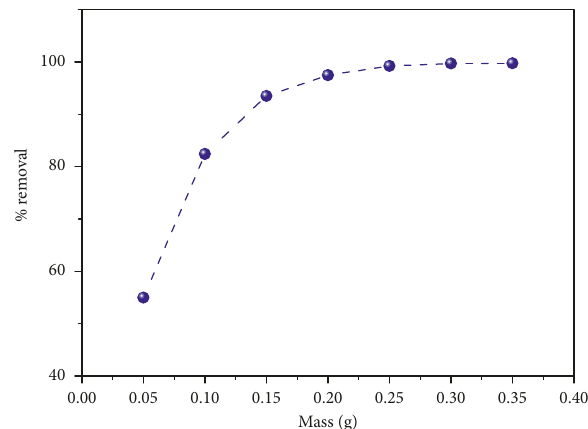
Figure 4: Effect of adsorbent dose on the removal efficiency.